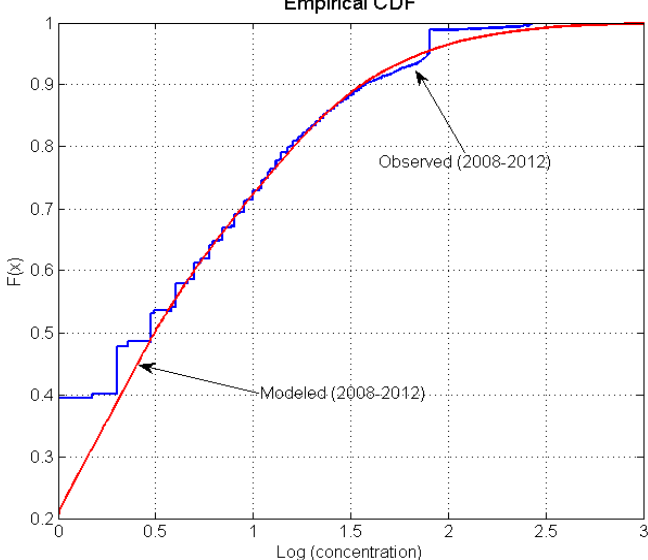
Figure 12. Comparison of cumulative distribution of modeled and observed fecal coliform concentrations at all stations from 2008 to 2012.